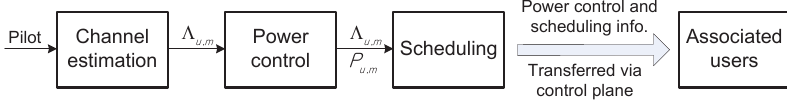
Figure 2. Control plane procedure for power control and